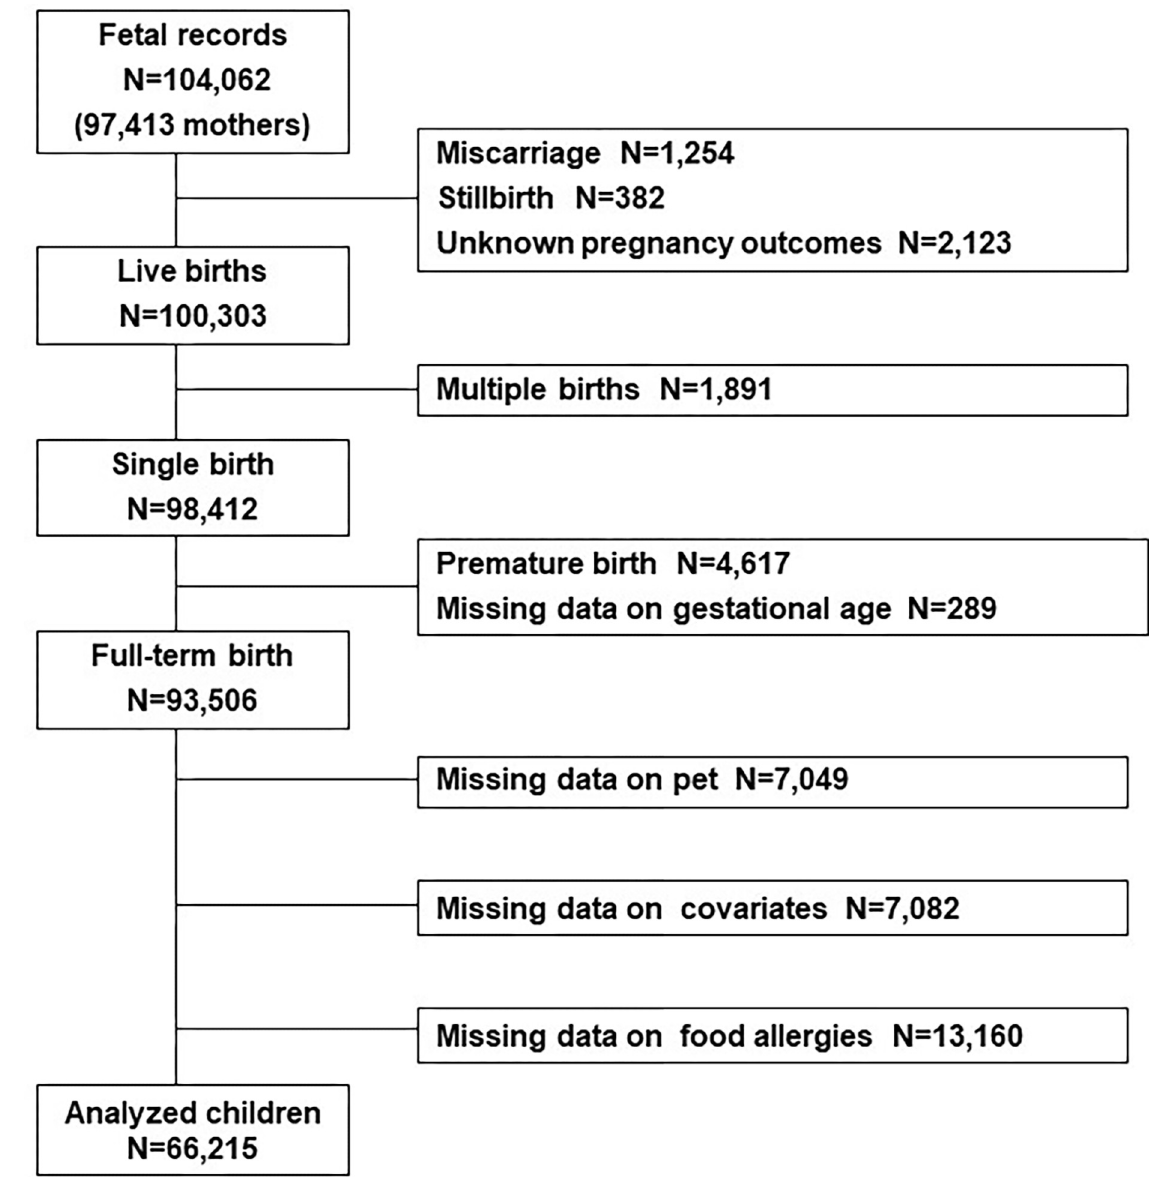
Fig 1. Flowchart of study participant